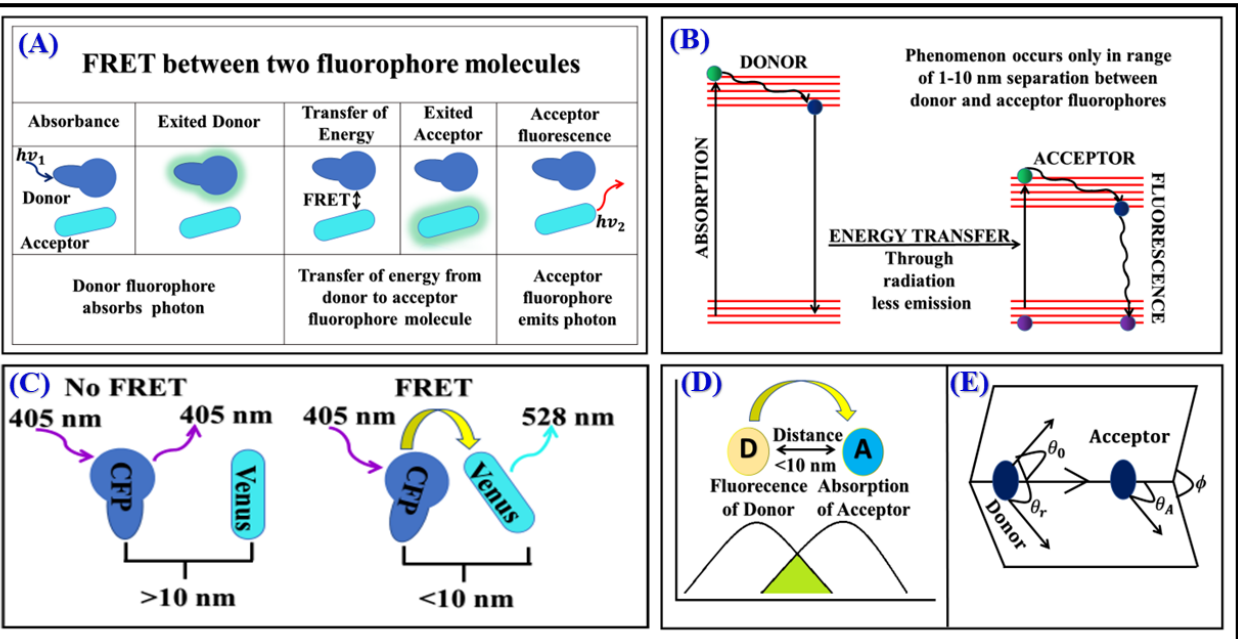
Figure 2. ( A ) Energy transfer between two fluorophore molecules. ( B ) Jablonski diagram for do- nor–acceptor pair in FRET. ( C ) Orientation of donor–acceptor pair, parallel to each other for maximum transfer of energy represented by spectral overlapping of emission spectra of donor ( D ) and absorption spectra of an acceptor ( A ). ( D ) Overlapping integral during FRET and ( E ) dipole–dipole orientation for maximum transfer of energy.